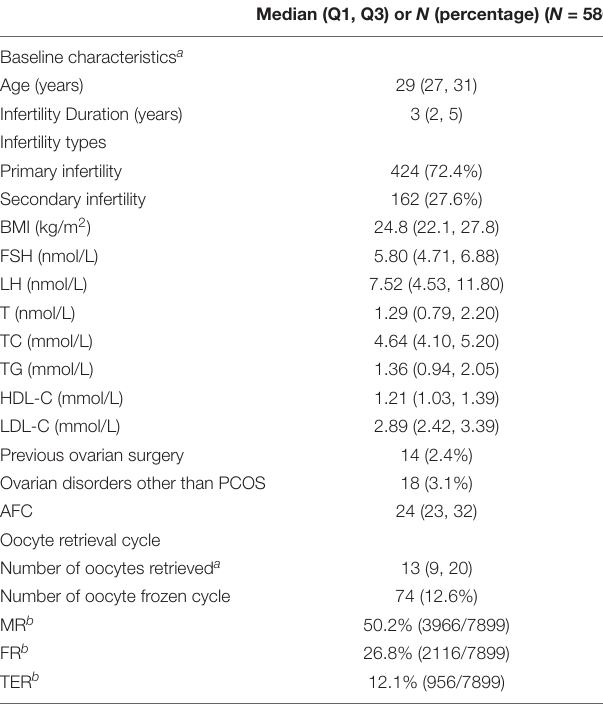
TABLE 1 | Baseline characteristics, oocyte maturation and embryo development index of